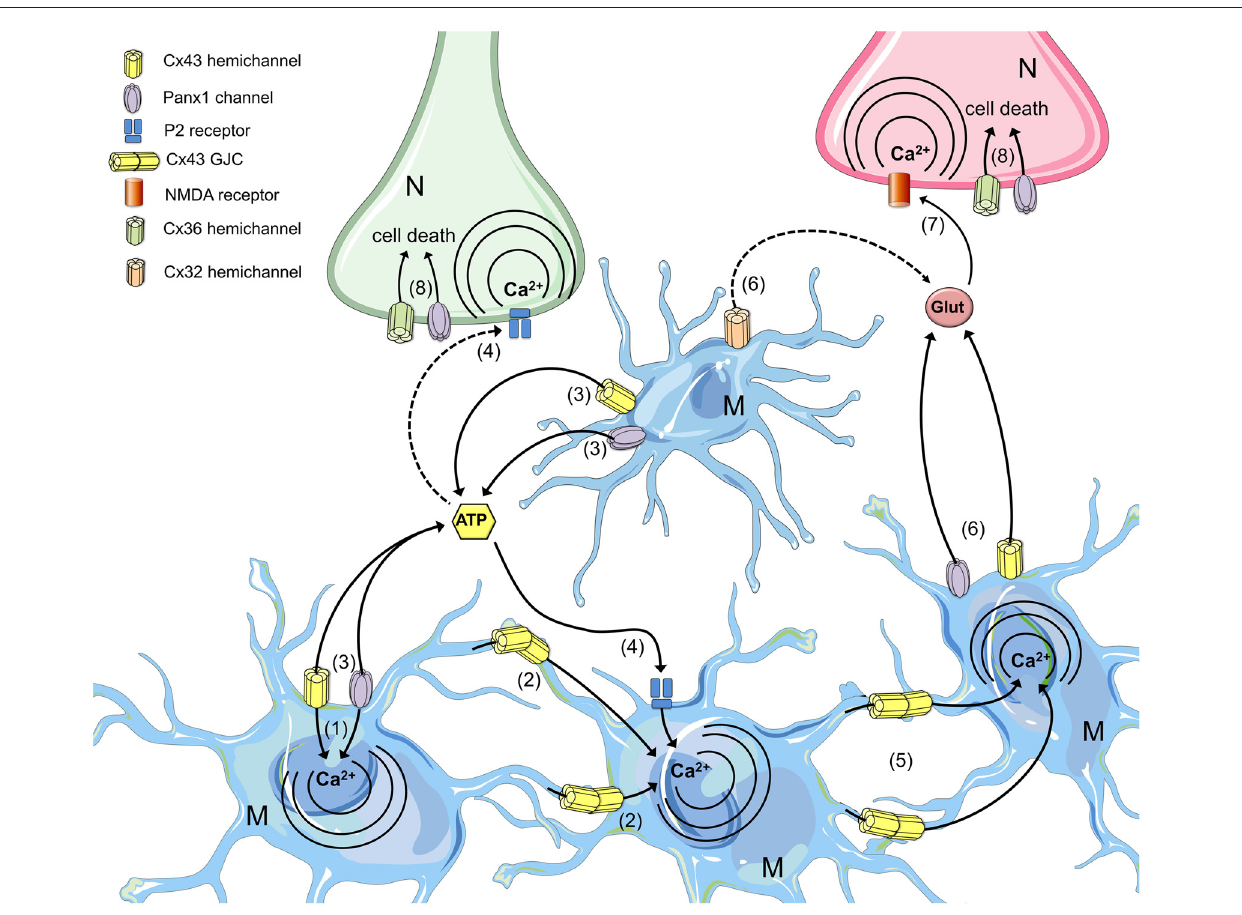
FIGURE 4 | The roles of microglial connexin- and pannexin-based channels in neurodegeneration. Under progressive inflammatory conditions, cytokine production and redox imbalance increase the opening of HCs and pannexons in microglia, permitting the influx of Ca 2 + (1) and its spread to neighboring cells through GJCs (2). Hemichannel and pannexon opening in microglia favor the release of ATP (3), which diffuses through the extracellular space to activate membrane purinergic (P2) receptors (4). Intercellular Ca 2 + waves propagated via GJCs increase the [Ca 2 + ] i in distant microglia (5), facilitating the release of glutamate through microglial HCs/pannexons (6) and the further activation of neuronal n-methyl-d-aspartate (NMDA) receptors (7). P2 and NMDA receptor activation in neurons increase the activity of neuronal Panx1 channels and Cx36 HCs, impairing the electrochemical and Ca 2 + imbalance that results in cell death (8).